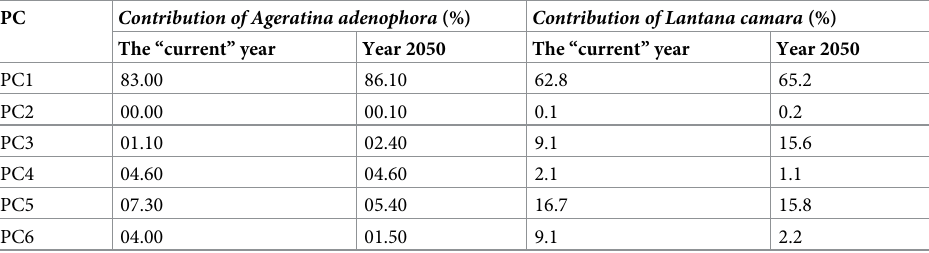
Table 3. Relative contributions of each principal component (PC) are used in all the MaxEnt models.